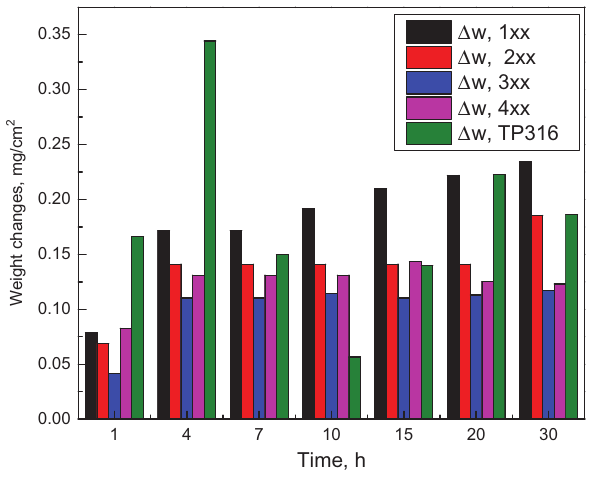
Figure 5: Weight changes for four test materials and reference TP316 at 700°C in air.